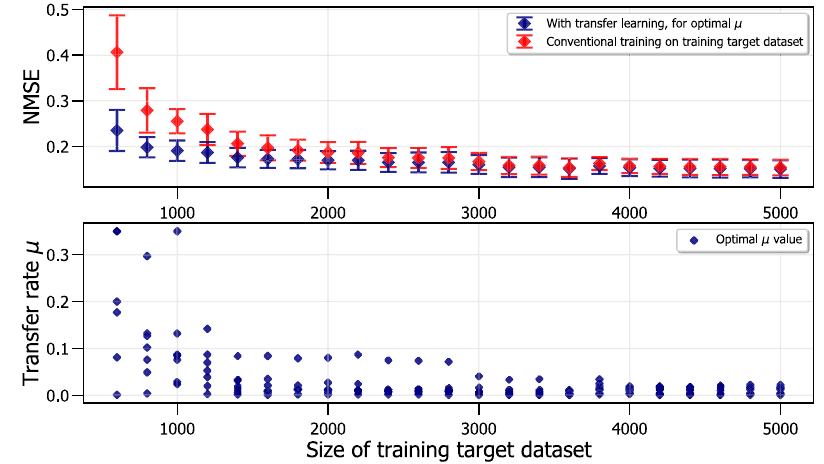
Figure 4: Mean and standard deviation of NMSE as a function of the training target dataset size for predicting the coordinates of Lorenz systems with different 𝜌 parameters, using transfer learning or conventional train-